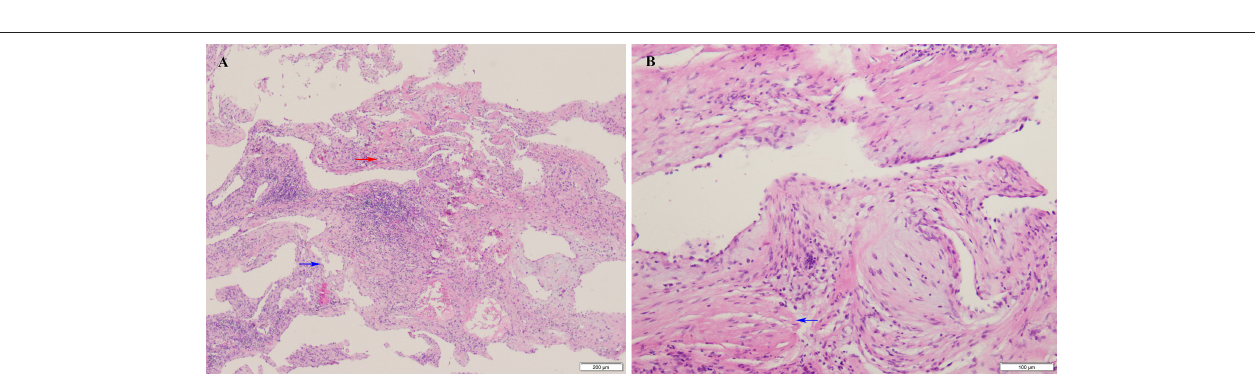
FIGURE 3 | (A) The mass located in the right ventricle and was attached to the interventricular septum (white arrow). (B) The mass were removed completely and the IVS was intact without perforation (black arrow). RA, right atrium; RV, right ventricle; IVS, interventricular septum; SCTV, septal cusp of tricuspid valve; PM, papillary muscles.